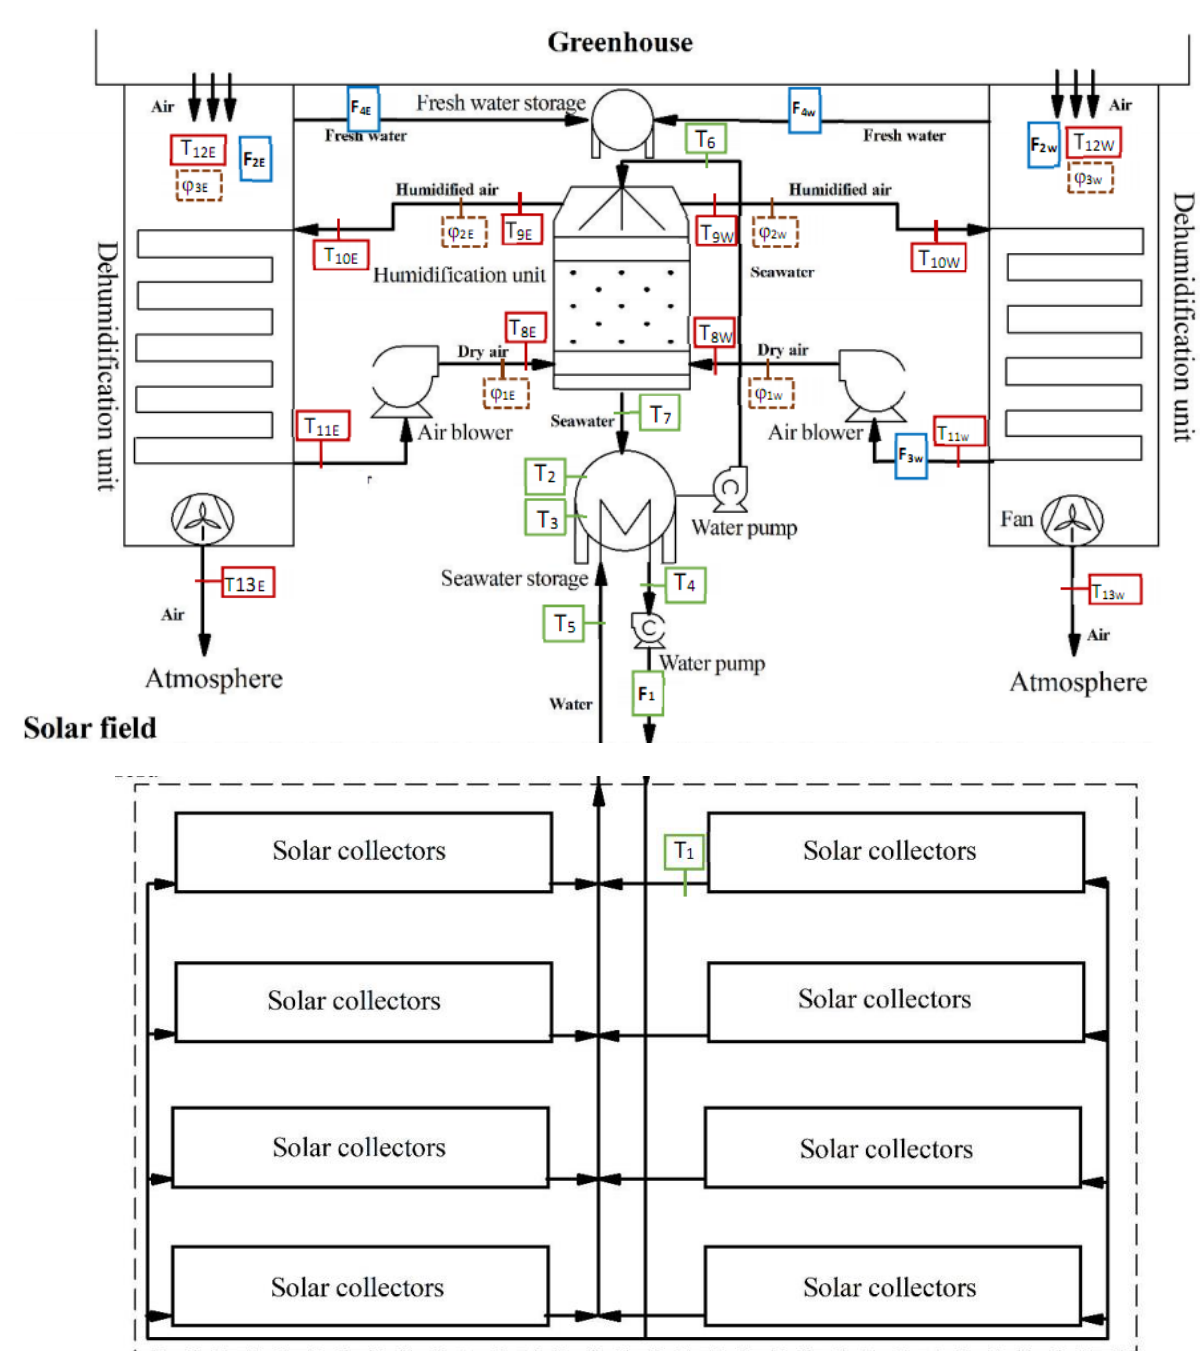
Figure 8. Position of measuring sensors.